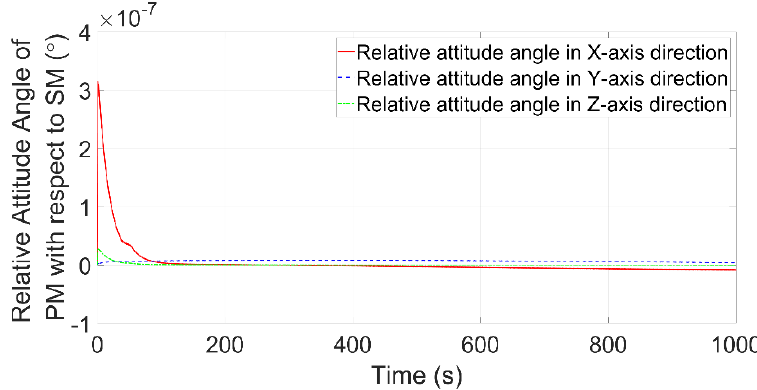
Figure 6. Attitude angle of the PM with respect to the SM.